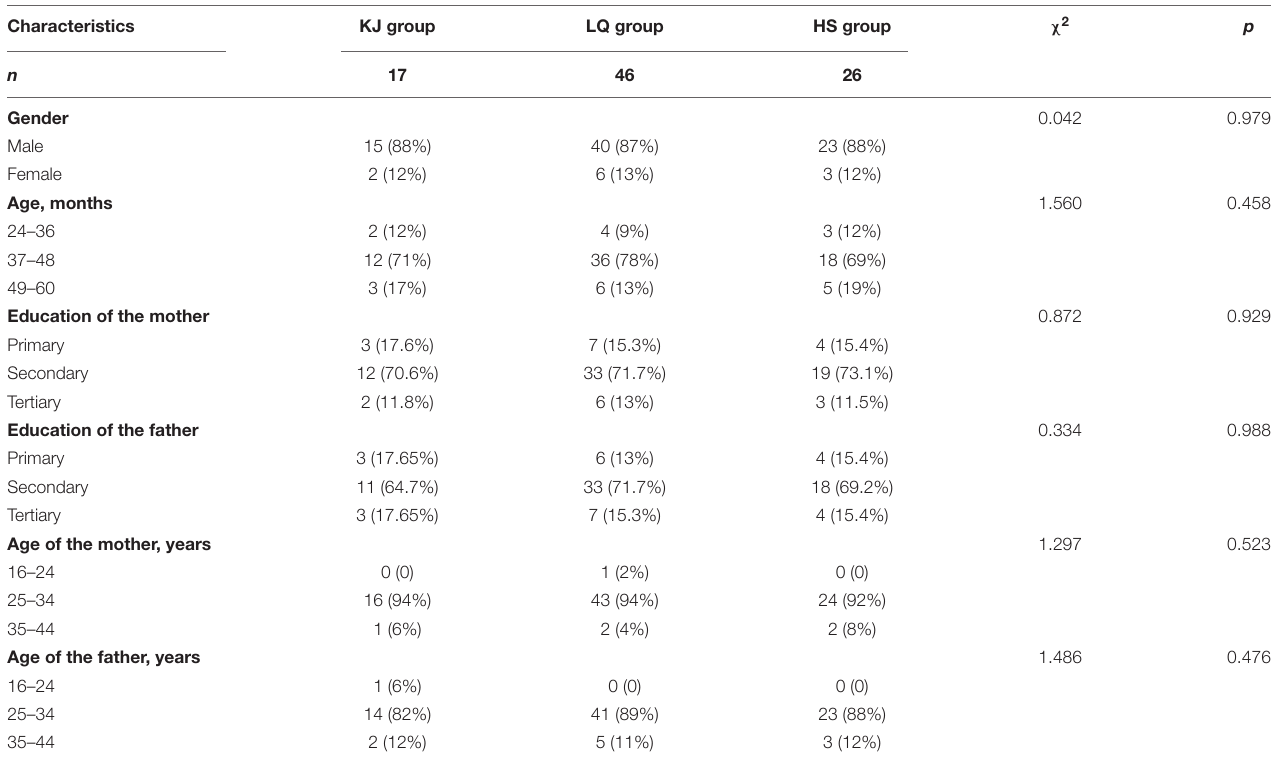
TABLE 2 | Patient demographic characteristics in the three